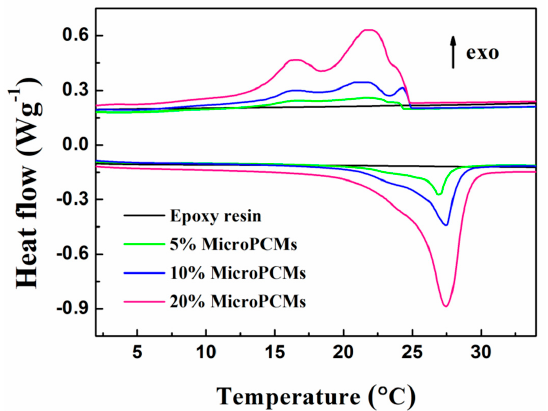
Figure 8. DSC curves of pure epoxy resin and MicroPCMs/epoxy composites with different MicroPCM contents.